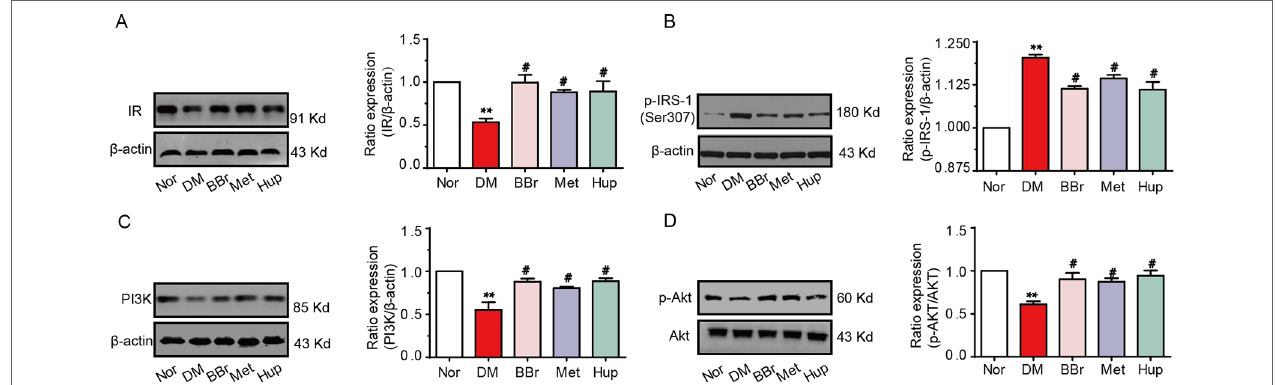
FIGURE 5 | Berberine improves insulin signaling pathway. Western-blot was performed to evaluate the protein expression of IR (A) , p-IRS-1 ser307 (B) , PI3K (C) and p-Akt (D) in hippocampus, n = 3. ** P < 0.01 vs. Nor; # P < 0.05 vs.